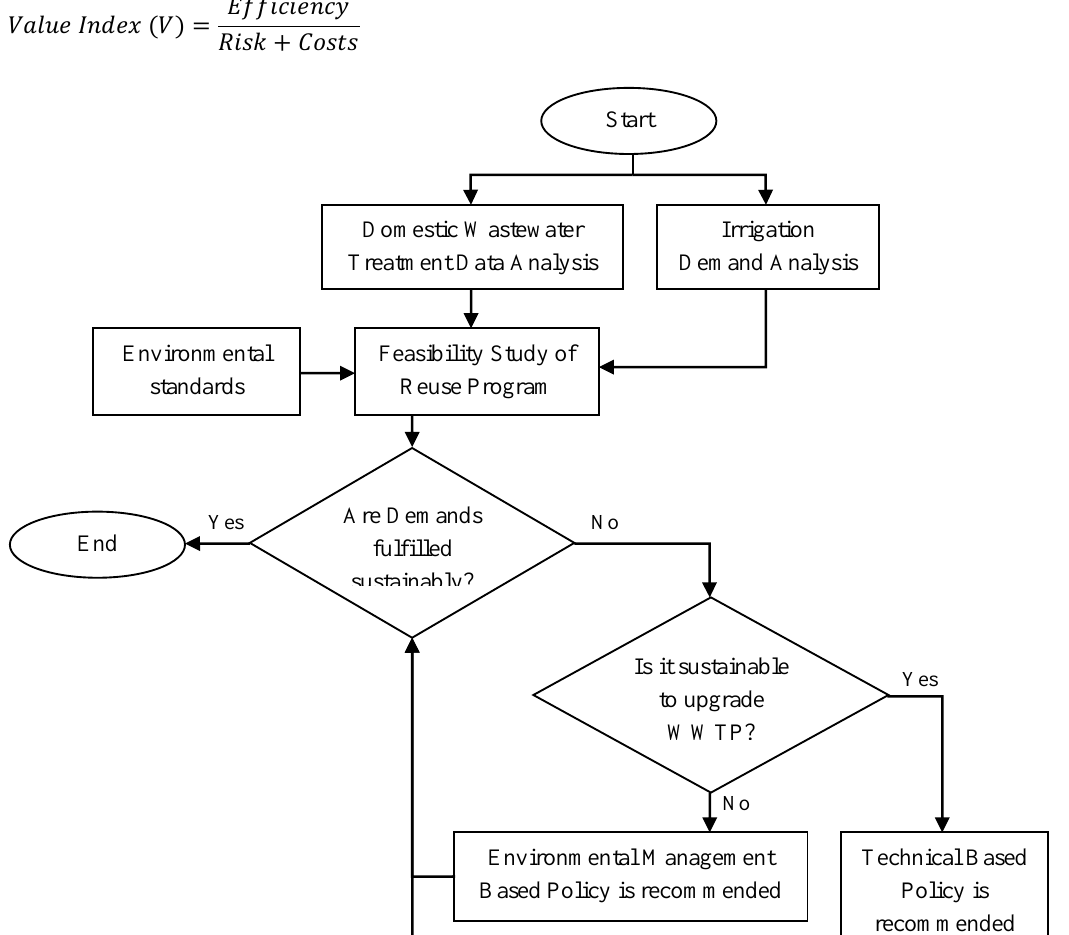
Figure 1. Decision making flow chart on upgrading wastewater treatment plants (WWTPs) based on reuse